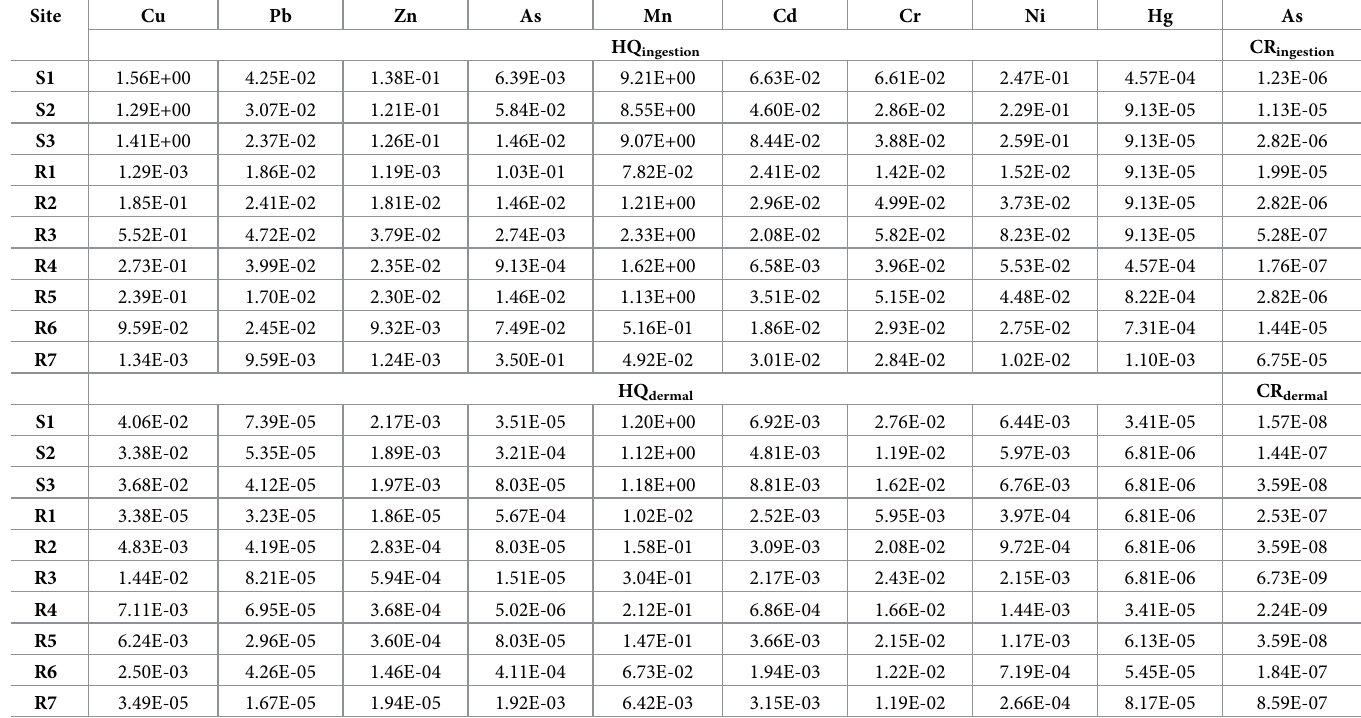
Table 7. Hazard quotient (HQ) and cancer risk (CR) of heavy metals from Rongna River for